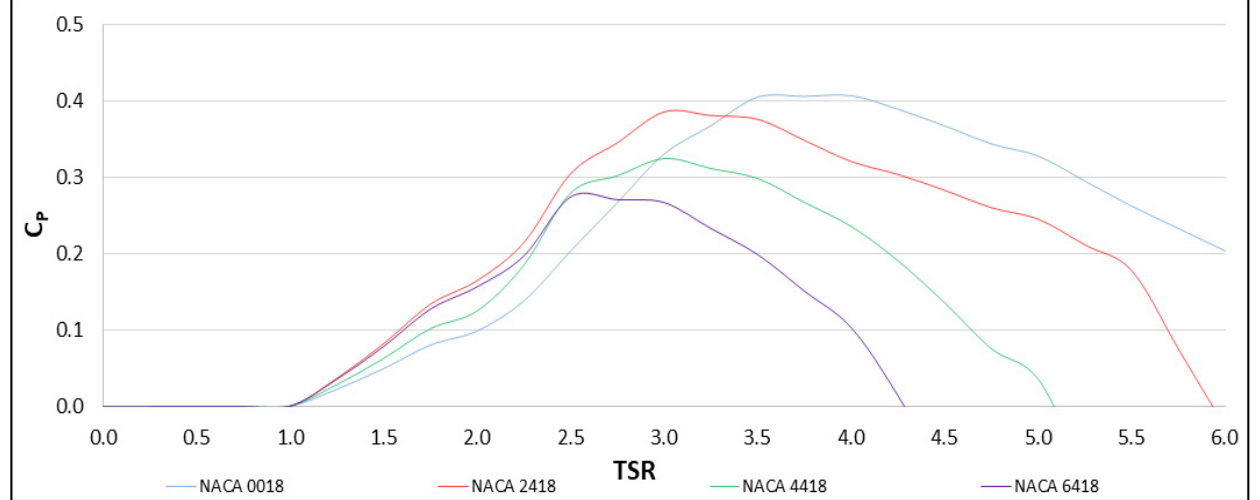
Figure 5. Coefficient of power vs. TSR plot for different airfoil camber.